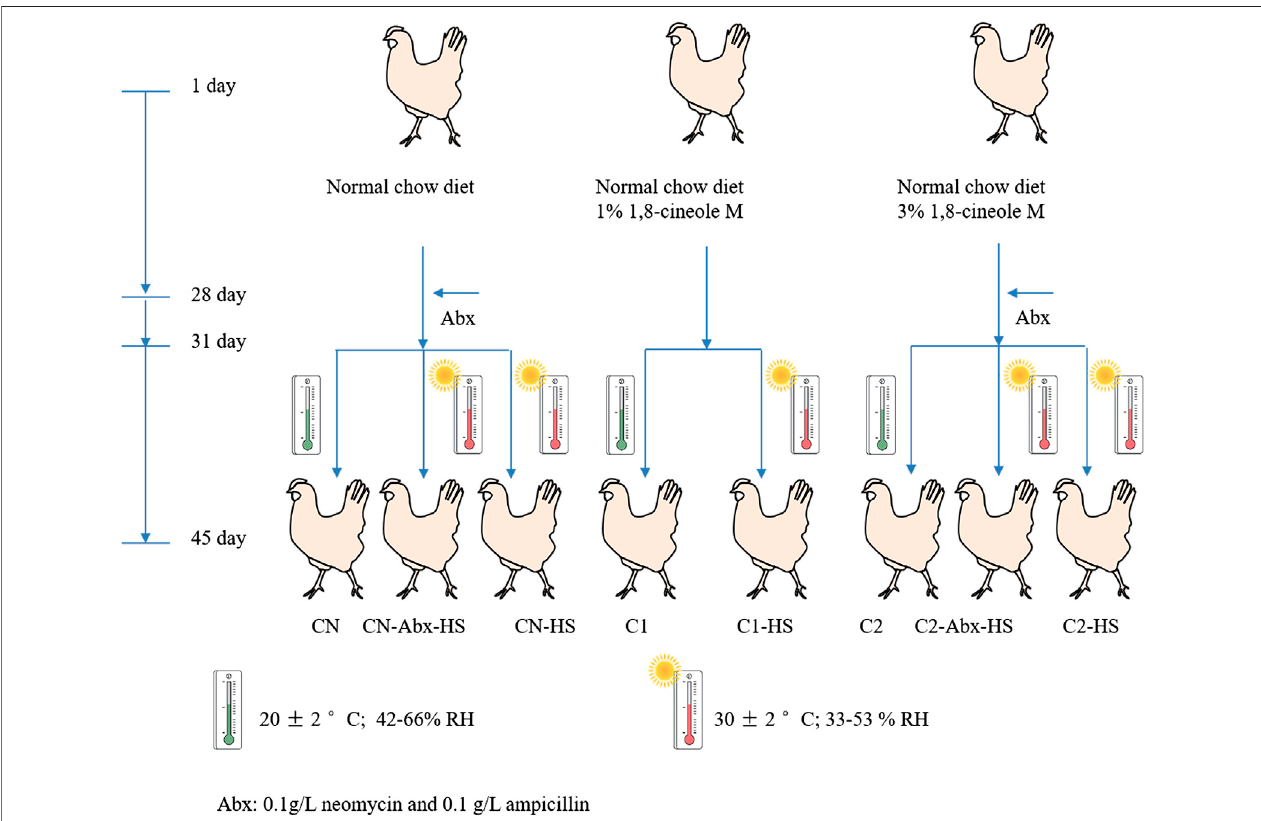
FIGURE 1 | Flow chart of chicken processing. Notes: The chickens were separated into eight groups with twenty chickens per group for observation of performanceparameters.Sixofthechickensfromeachtestinggroupweresubjectedtomolecularbiologicalindextesting.CN:normalchow-dietforforty- fi vedays;CN- HS:normalchow-dietforforty- fi vedaysandheatstresstreatmentonDay31ofexperimentfor fi fteendays;C1:1%1,8-cineolemicrocapsulesforforty- fi vedays;C1-HS: 1% cineole microcapsules for forty- fi ve days and heat stress treatment on Day 31 of experiment for fi fteen days; C2: 3% 1,8-cineole microcapsules for forty- fi ve days; C2-HS: 3% 1,8-cineole microcapsules for forty- fi ve days and heat stress treatment on Day 31 of experiment for fi fteen days; CN-Abx-HS: normal chow-diet for forty- fi ve days and Abx for three days on Day 28and HS treatment on Day 31for fi fteen days. C2-Abx-HS: 3% 1,8-cineole microcapsules for forty- fi ve days and Abx for three days on Day 28 and HS treatment on Day 31 for fi fteen days.